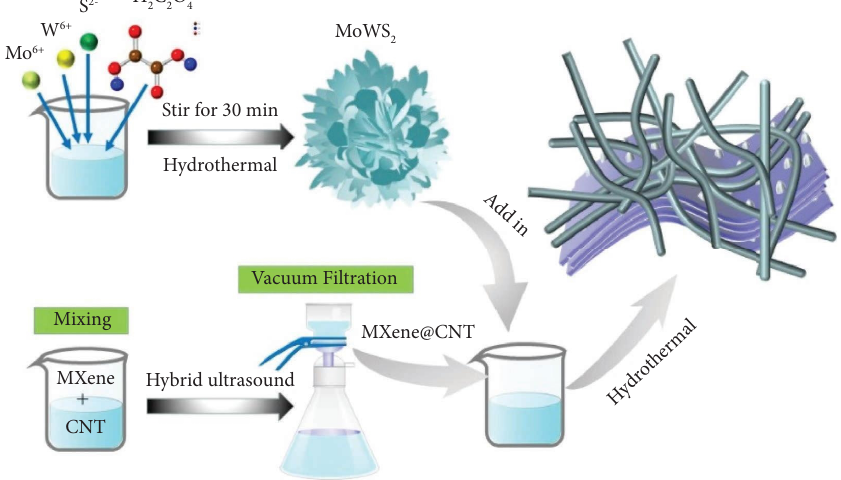
Figure 1: Preparation fowchart of MoWS